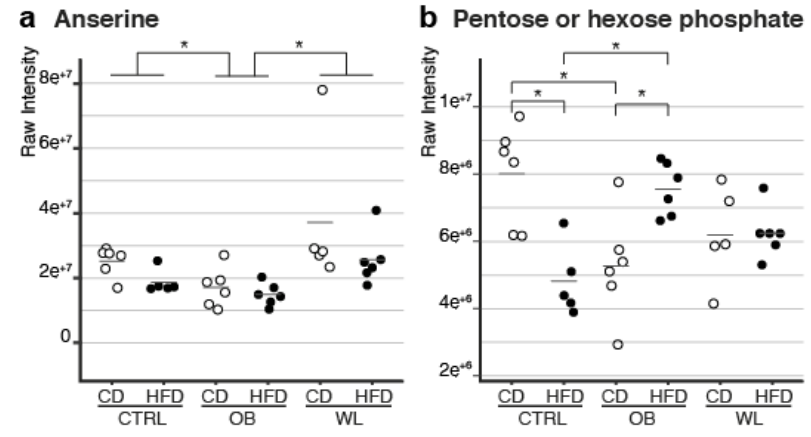
Figure 5. Two liver metabolite levels were affected by maternal diet group. ( a ) In the OB offspring, the abundance of anserine was significantly lower than that in CTRL and WL o ff spring. Anserine the abundance of anserine was significantly lower than that in CTRL and WL offspring. Anserine abundance did not di ff er significantly between the CTRL and WL o ff spring. This e ff ect was independent abundance did not differ significantly between the CTRL and WL offspring. This effect was of the post-weaning diet. ( b ) In the CTRL o ff spring, the abundance of P / H-P was significantly lower in independent of the post-weaning diet. ( b ) In the CTRL offspring, the abundance of P/H-P was animals fed the HFD. In the OB o ff spring, the opposite trend was observed: the abundance of P / H-P was significantly lower in animals fed the HFD. In the OB offspring, the opposite trend was observed: the significantly increased by the HFD. Furthermore, CTRL-CD and OB-CD o ff spring di ff ered significantly abundance of P/H-P was significantly increased by the HFD. Furthermore, CTRL-CD and OB-CD from each other, as did CTRL-HFD and OB-HFD o ff spring. Finally, WL-CD and WL-HFD o ff spring offspring differed significantly from each other, as did CTRL-HFD and OB-HFD offspring. Finally, were not significantly di ff erent from other o ff spring groups. Each dot represents an individual, and * WL-CD and WL-HFD offspring were not significantly different from other offspring groups. indicates an adjusted p -value < Each dot represents an individual, and * indicates an adjusted p -value < 0.05.